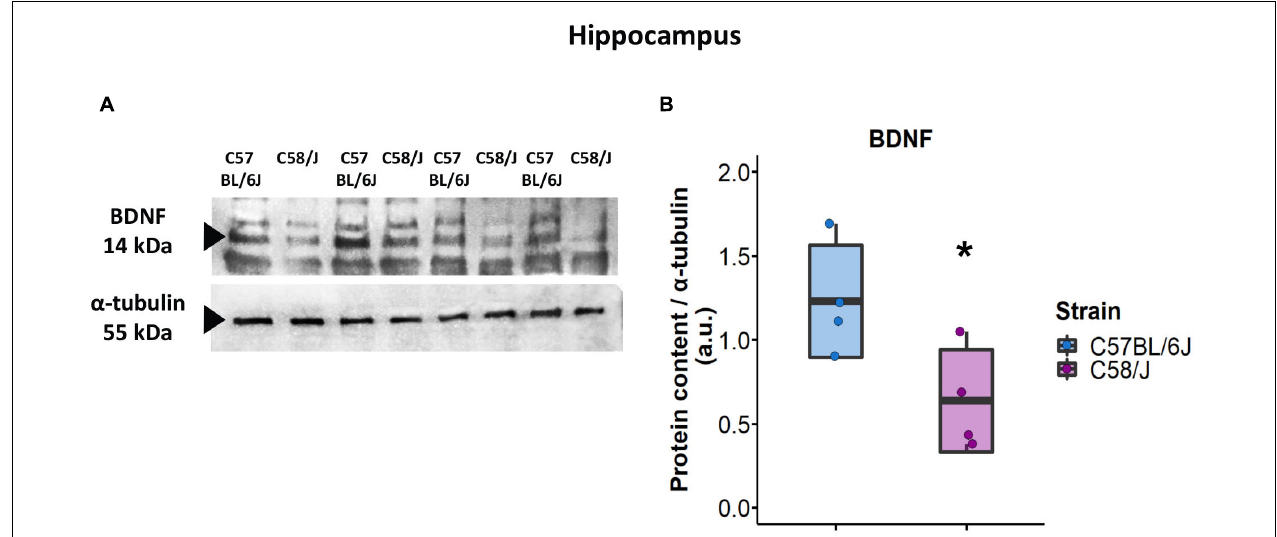
FIGURE 6 | BDNF protein content in the hippocampus of C58/J mice. Western blot of BDNF content in the hippocampus of C57 BL/6J (neurotypical phenotype) and C58/J (autistic-like phenotype) mice (A) . Semi-quantitative analysis of BDNF densitometry for both strains (B) . Results are expressed as mean ± SD; n = 4 mice per strain. t -test: * p <